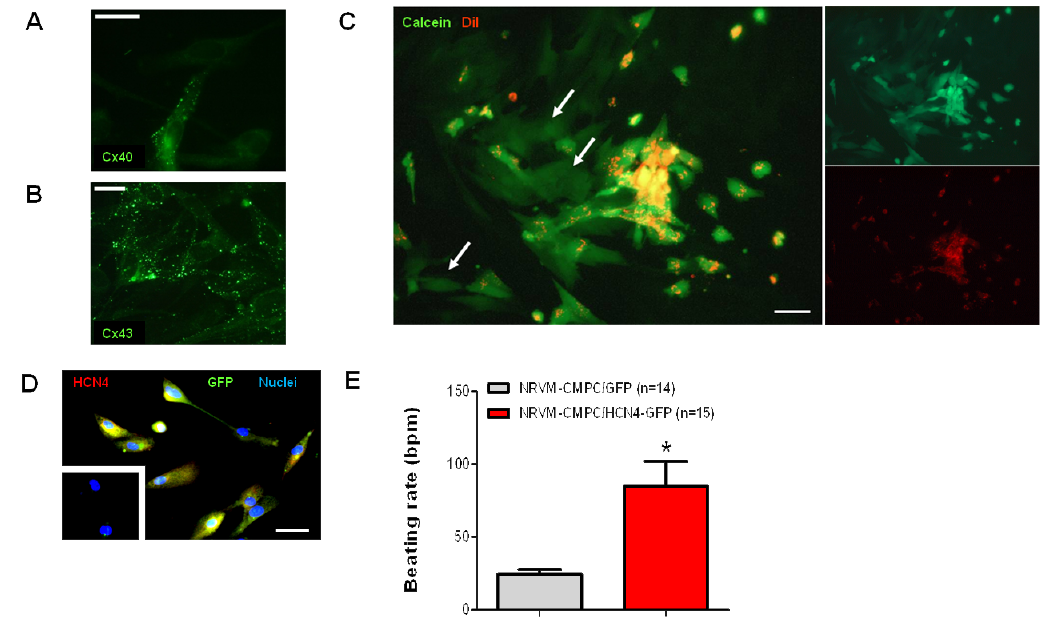
Figure 2. Functional coupling of CMPCs to cardiomyocytes. ( A , B ) Immunolabeling of connexin proteins Cx40 and Cx43. Scale bars represent 30 and 25 µ m, respectively. ( C ) Fluorescent microscopy of dye transfer from CMPCs labeled with DiI (red) and Calcein (green) to unlabeled cardiomyocytes. Cardiomyocytes that have imported Calcein are indicated by white arrows. Scale bar represents 45 µ m. ( D ) Immunolabeling of GFP (green) and HCN4 (red) in CMPCs transduced with LV-HCN4-GFP. Yellow indicates co-staining. Nuclei were counterstained blue with DAPI. Non-transduced CMPCs, shown in the inset, stained negative for GFP and HCN4. Scale bar represents 45 µ m. ( E ) Average beating rates of neonatal rat ventricular myocyte (NRVM) monolayers co-cultured with CMPCs expressing GFP alone (grey) and HCN4 and GFP (red). * indicates P < 0.05.